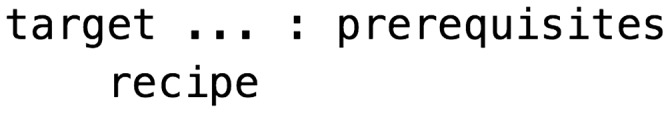
The basic Make rule syntax.